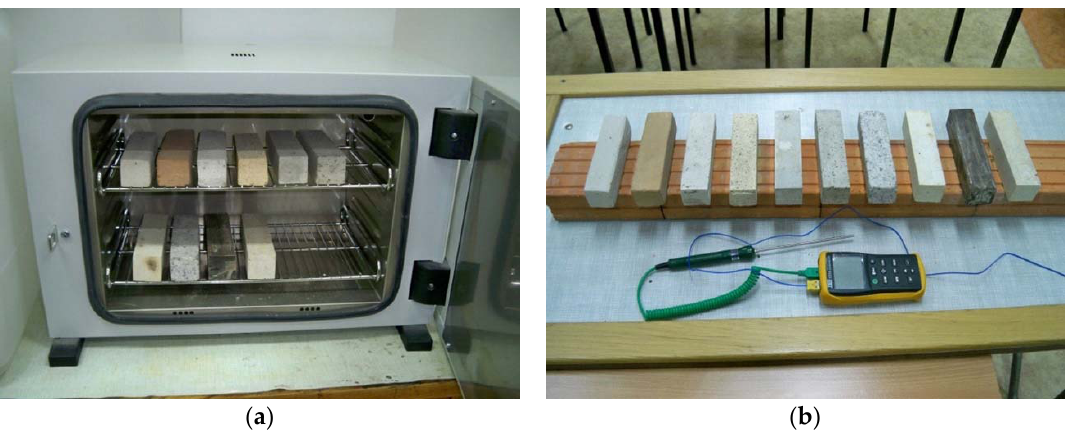
Figure 1. The samples used for testing: ( a ) in a laboratory dryer; and ( b ) on the temperature measurement stand.